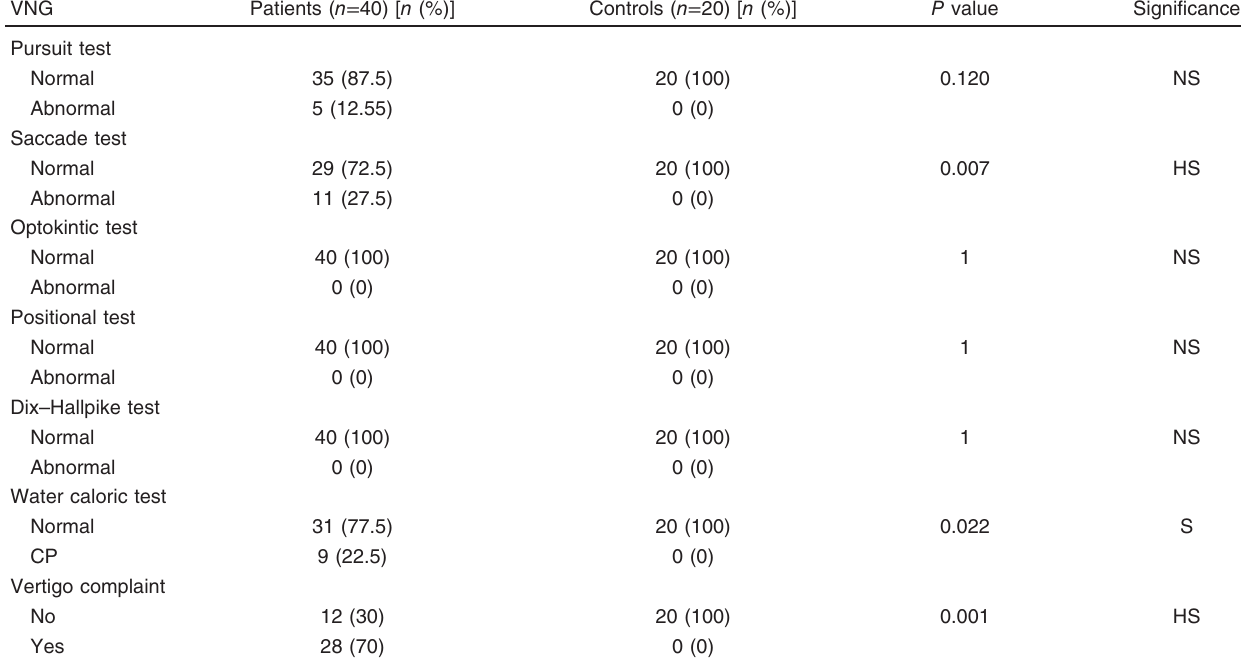
Table 3 Comparison between rheumatoid arthritis patients and the control group as regards videonystagmography results and vertigo complaint VNG